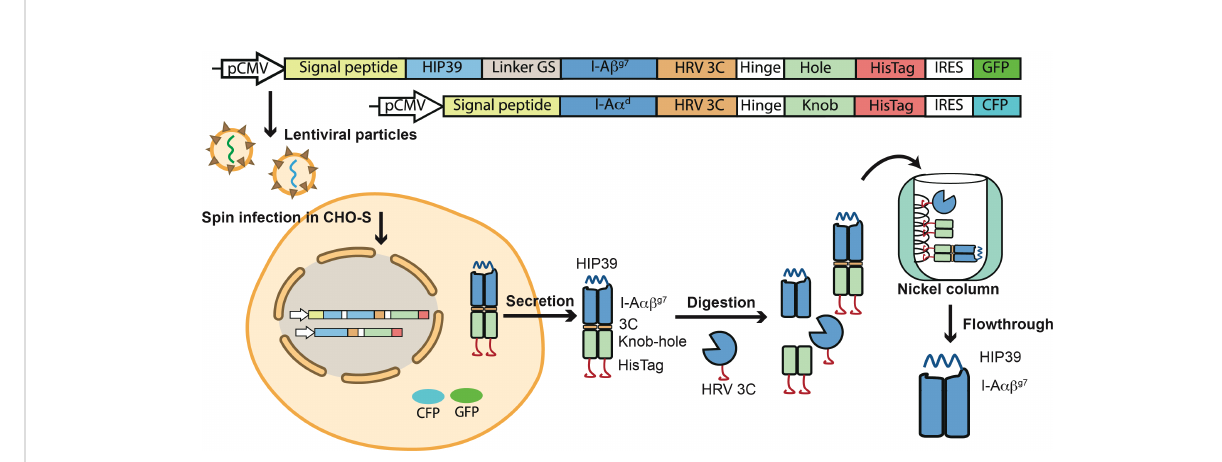
FIGURE 1 Production of the 4.1-TCR and HIP39/I-A g7 complexes. Top, lentiviral constructs encoding the HIP39/I-A g7 . The HIP39 peptide sequence is tethered to the I-A b g7 chain via a fl exible GS linker. The HIP39-linker-I-A b g7 fusion was then fused to an Fc-knob carrying an upstream cleavage site for the HRV 3C enzyme, as well as a downstream 6xHis tag and an IRES-eGFP-coding cassette. The I-A a d chain was fused to an Fc-hole, also carrying an upstream 3C cleavage site and downstream 6xHis tag and an IRES-CFP-coding cassette. Bottom, transduced CHO-S cells were sorted for high levels of CFP and GFP expression and the corresponding cell culture supernatants used as a source of heterodimeric HIP39-I- A ab g7 -3C-KIH-HisTag molecules. The heterodimers were puri fi ed via protein G chromatography, digested with 6xHis-tagged HRV 3C and puri fi ed away from the KIH tail and the HRV 3C enzyme via sequential nickel-af fi nity and protein G